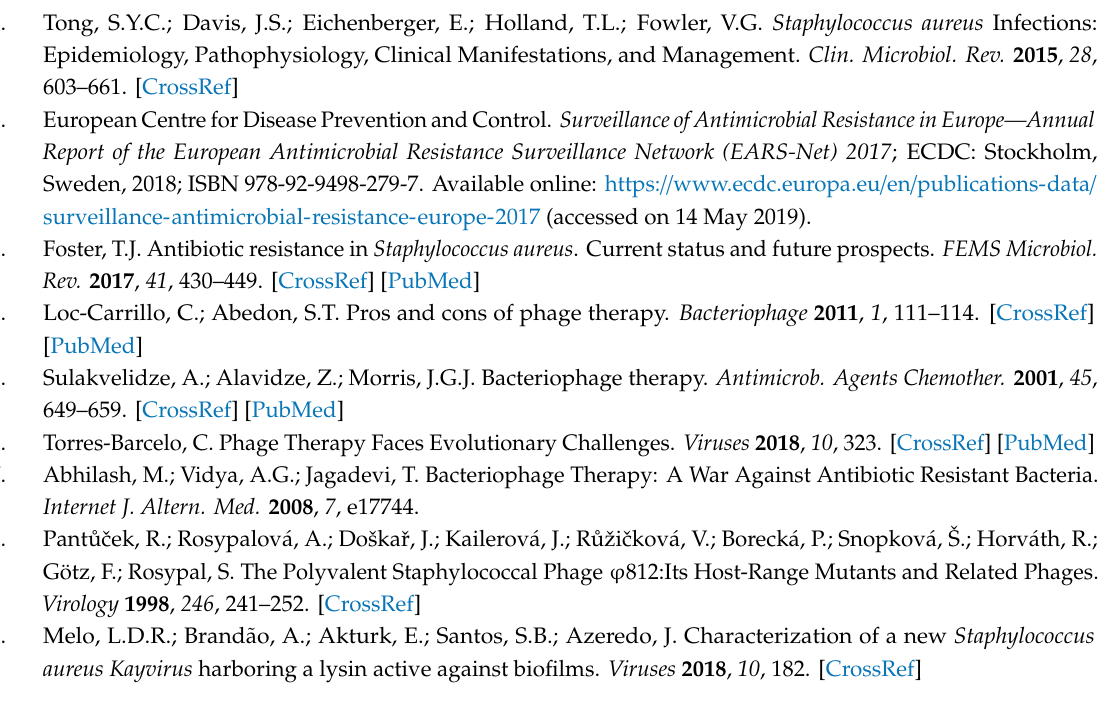
Figure S1: Genome organization of bacteriophage vB_SauM_A, Table S1: Genome annotation of bacteriophage vB_SauM_A, Figure S2: Genome organization of bacteriophage vB_SauM_C, Table S2: Genome annotation of bacteriophage vB_SauM_C, Figure S3: Genome organization of bacteriophage vB_SauM_D, Table S3: Genome annotation of bacteriophage